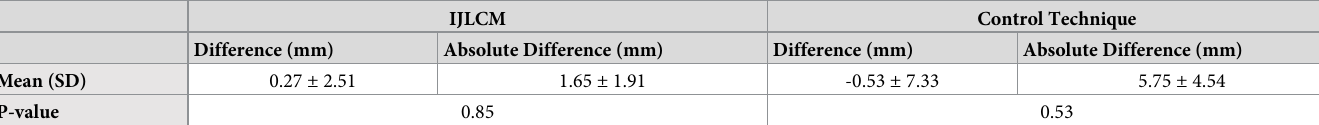
Table 2. Analysis of differences in post-operative joint line height measurements performed by senior orthopaedic